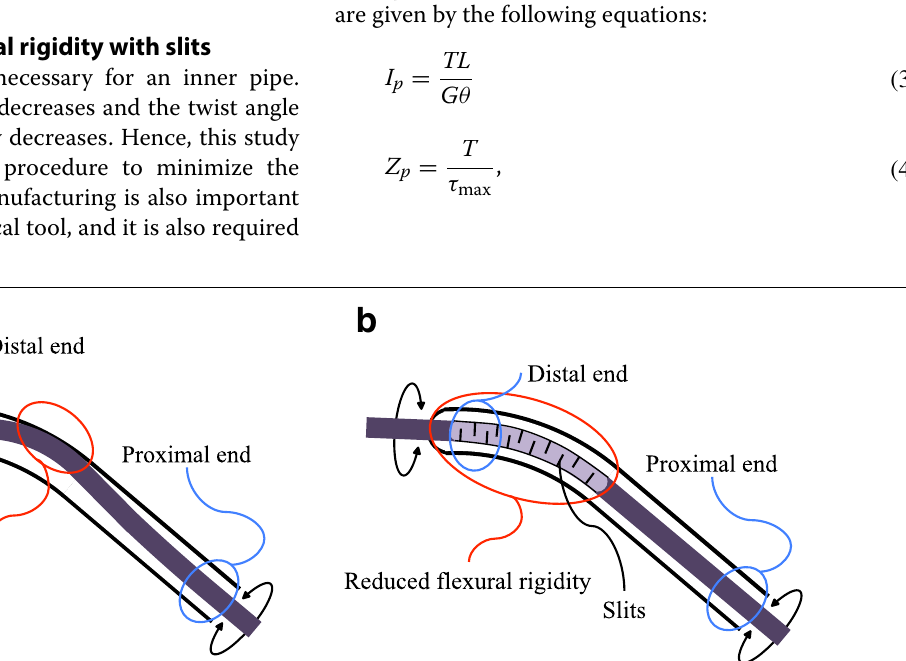
Fig. 2 Inner pipe with insufficient flexibility. a Inner pipe with insufficient flexibility. b Inner pipe with slits exhibiting sufficient